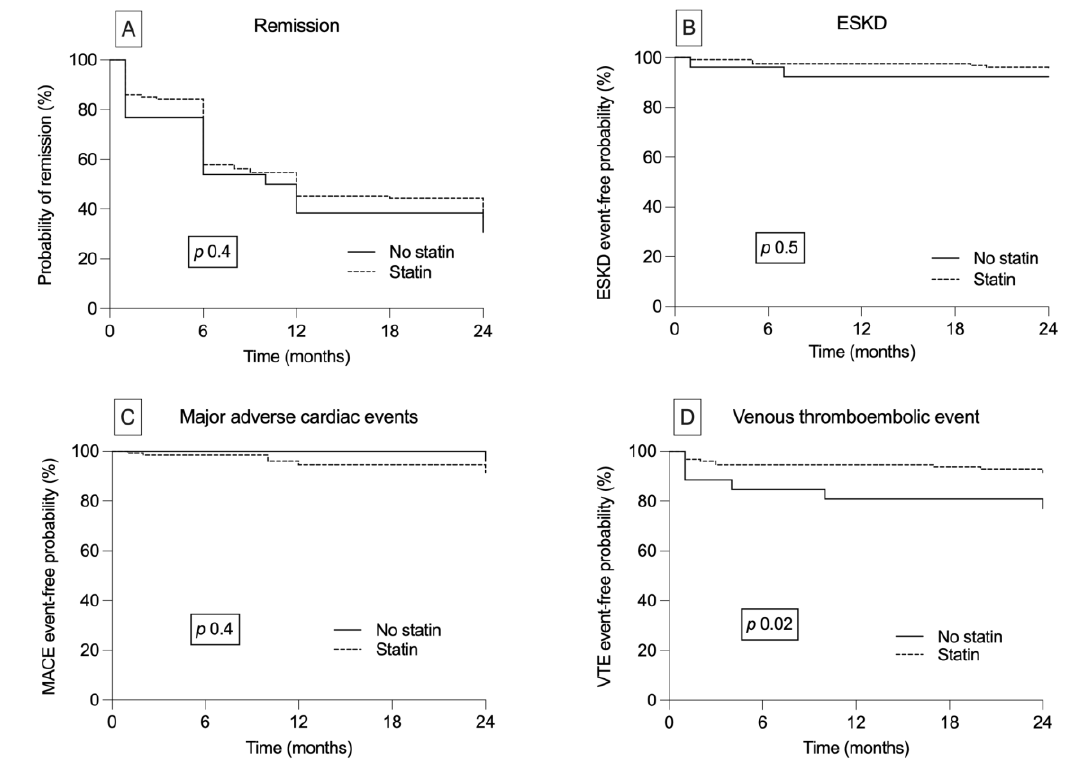
Figure 2. Cumulative probability of nephrotic syndrome remission ( A ) and of event-free survival: ( B ) End-stage kidney disease (ESKD), ( C ) Major cardiovascular events (MACE), ( D ) Venous throm- boembolic events (VTE) — according to statin therapy (Kaplan — Meier analysis).